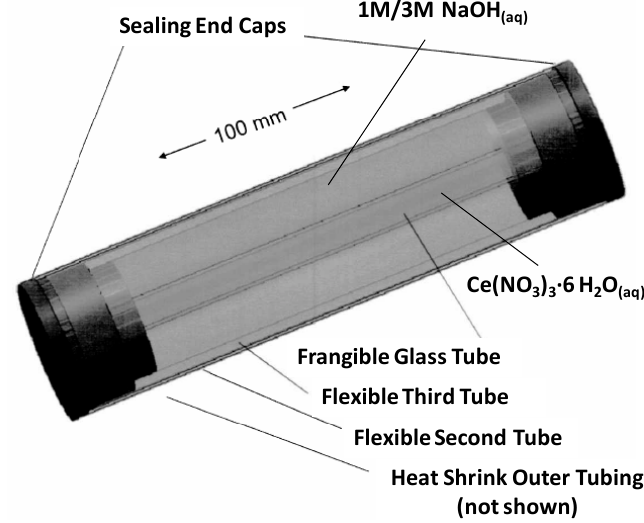
Figure 9. Schematic for the catalyst preparation